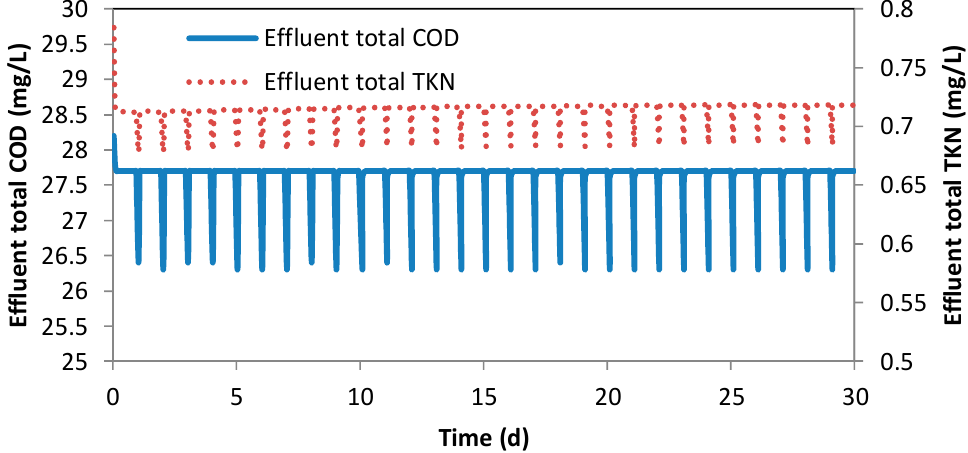
Figure 3. Evolution of the total COD and total TKN of the final e ffl uent during the 30 days of simulation for the PRWWTPs containing CAS + CAS processes.